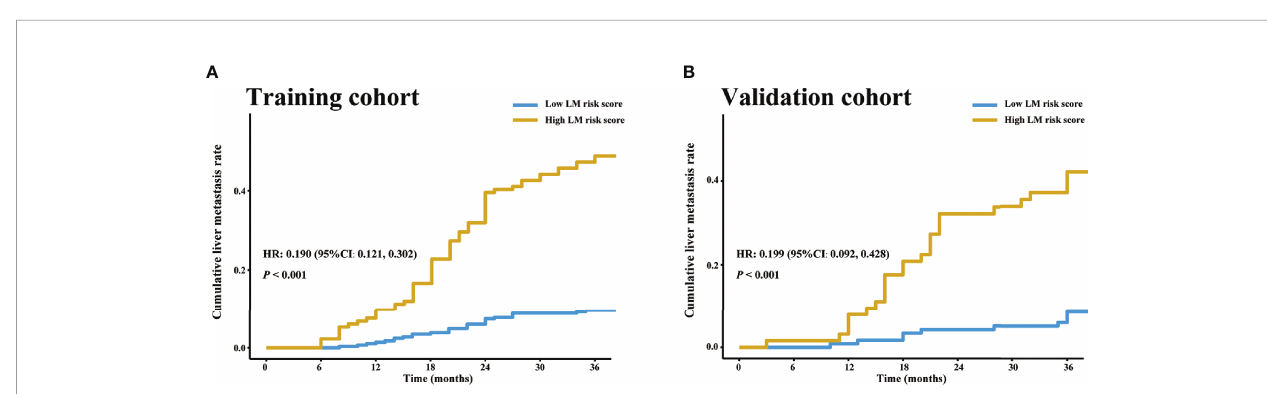
FIGURE 5 | LM risk score and LM in the training and validation cohorts. Cumulative LM rate strati fi ed by the LM risk score in the (A) training and (B) validation cohorts. The cumulative liver metastasis rates in the patients with high LM risk score were 48.1% (64/133) and 41.3% (26/63) in the training and validation cohorts, respectively, and the cumulative liver metastasis rates in the patients with low LM risk score were 9.5% (28/295) and 8.3% (10/120) in the training and validation cohorts, respectively. HR, hazard ratio; CI, con fi dence interval; LM, liver